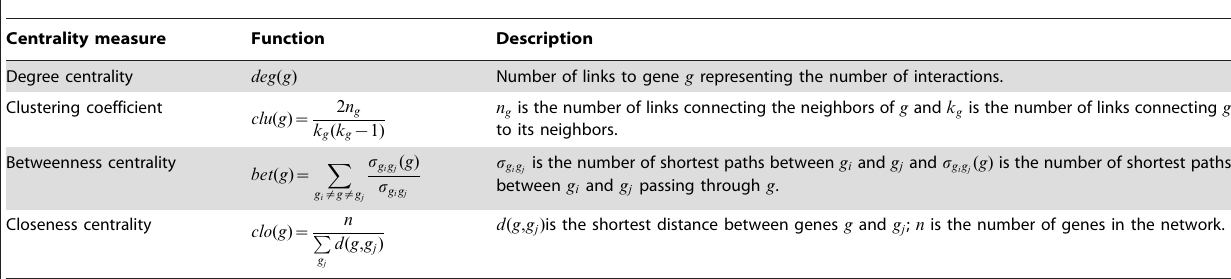
Table 1. Network centralities measures used as training features in graph2sig .